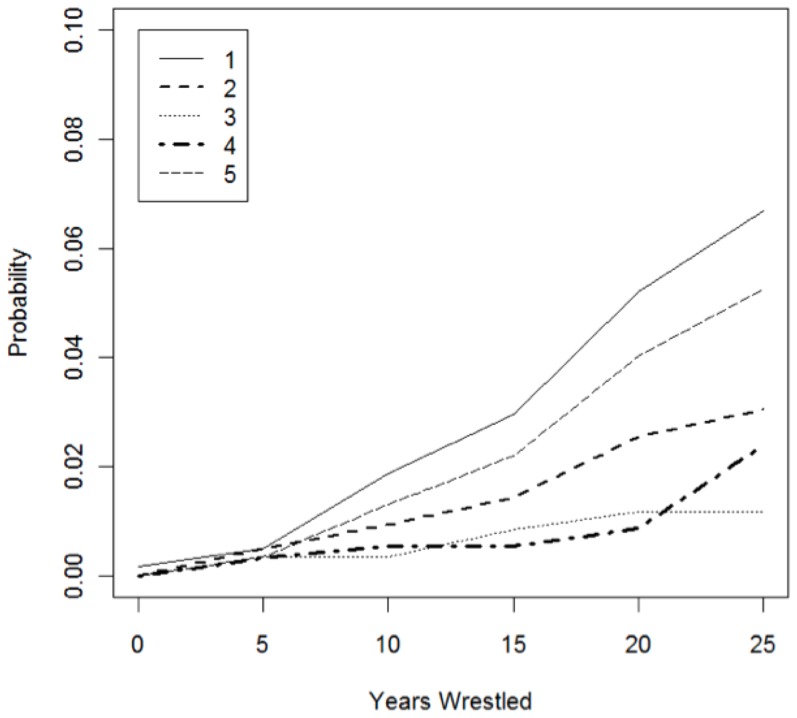
Cumulative incidence function estimates given years wrestled for cause of death.Figure 4 Note: 1 =  Cardiovascular-Related Death; 2 =  Drug-Related Death; 3 =  Non-Drug Suicide and Homicide; 4 =  Cancer Death; 5 =  Other Cause of Death.